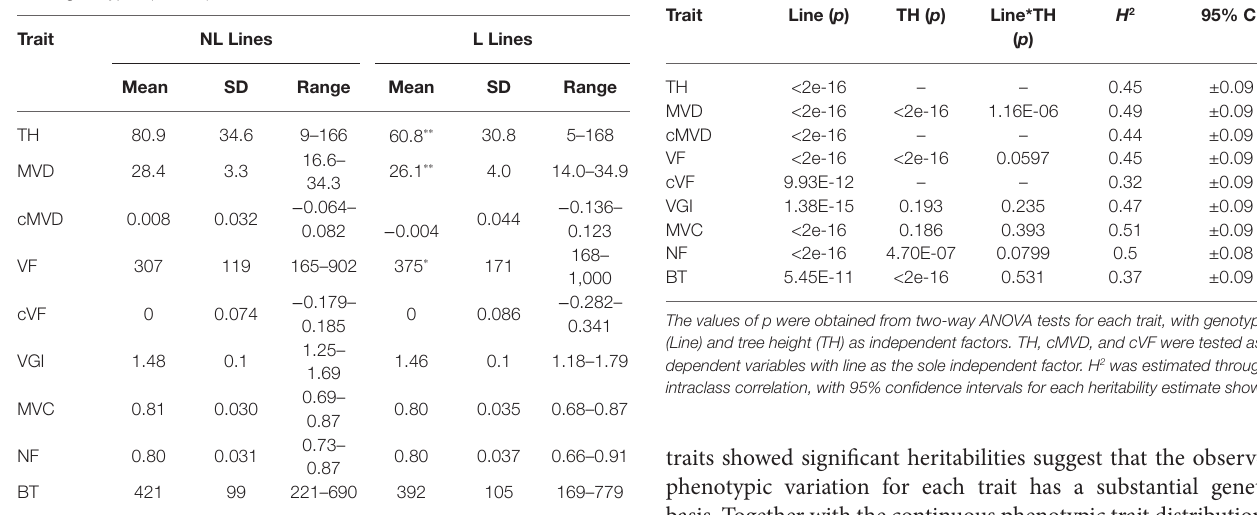
TABLE 2 | The means, standard deviations (SD), and ranges of phenotypic traits measured in 201 genotype poplar pedigree across non-lesion (NL Lines) and lesion genotypes (L Lines).